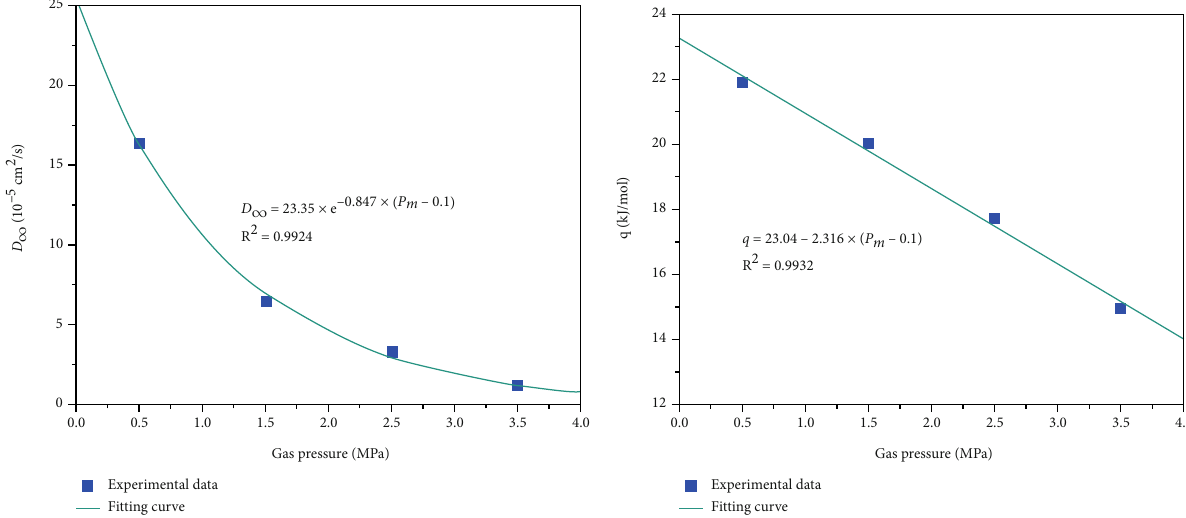
ð q Þ and gas ∞ ) and activation energy